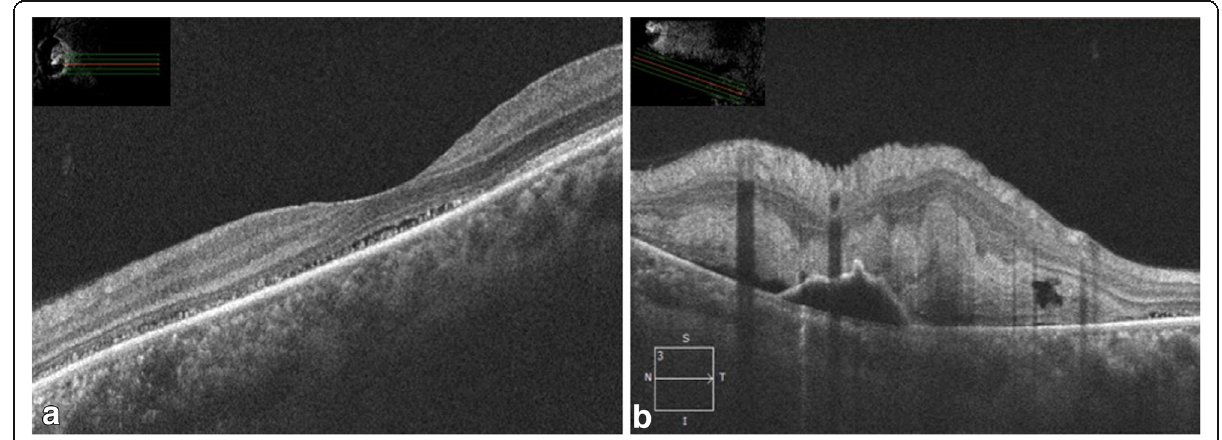
Fig. 2 a OCT scan of the left eye showing normal foveal contour with subretinal fluid and high reflective dots. b OCT scan through the retinochoroiditis lesion showing increased retinal thickening with a pigment epithelial detachment and subretinal